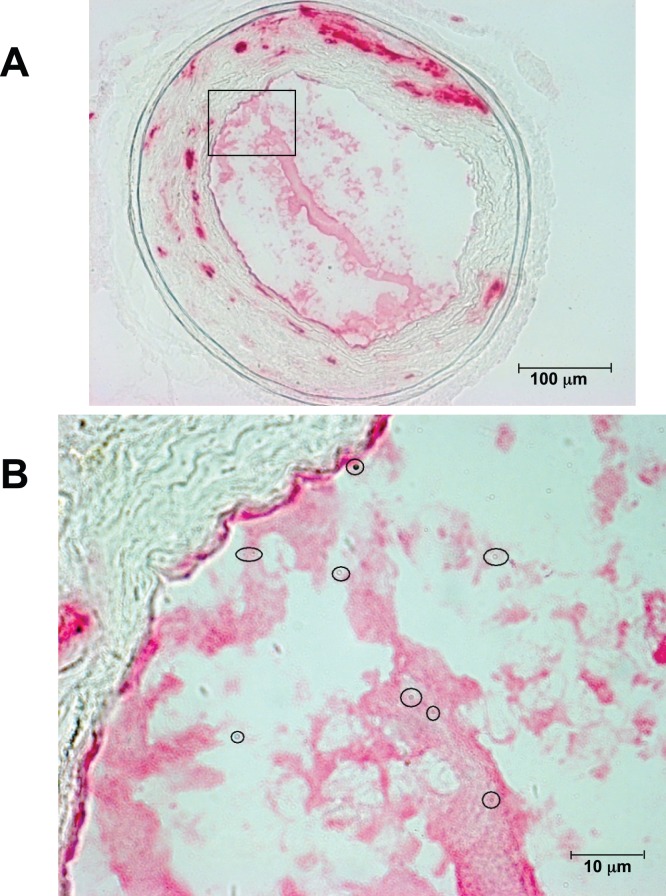
Histological identification of MPIOs.(A): Representative anti-CD41 immunostaining of a carotid artery section from a mouse receiving LIBS-MPIOs. (B) Enlargement of the area from (A) shows MPIOs inside the thrombus (circles). MPIOs can be recognized as regular round structures with a blue halo and a brownish inner colour.